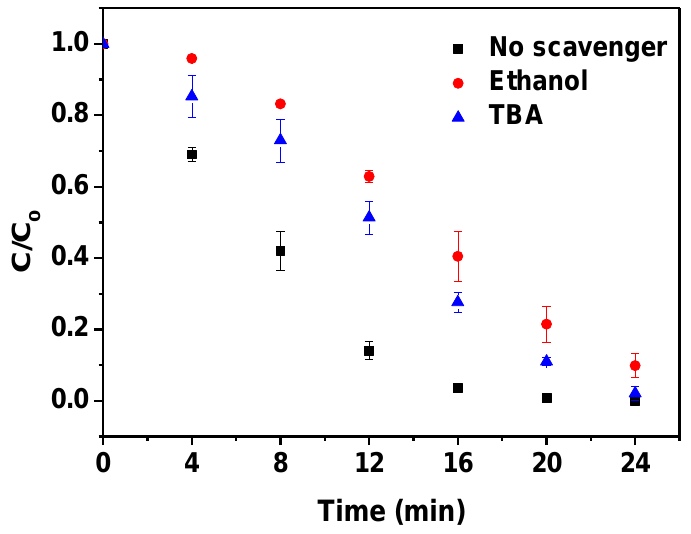
Figure 5. Oxytetracycline (OTC) degradation in the presence of scavengers ([OTC] 0 = 20 μM, [PS] 0 = 1 mM, [HWWC] 0 = 0.2 g/L, [scavenger] 0 = 10 mg/L, pH = 6). PS: persulfate; HWWC: hand-warmer waste catalyst.